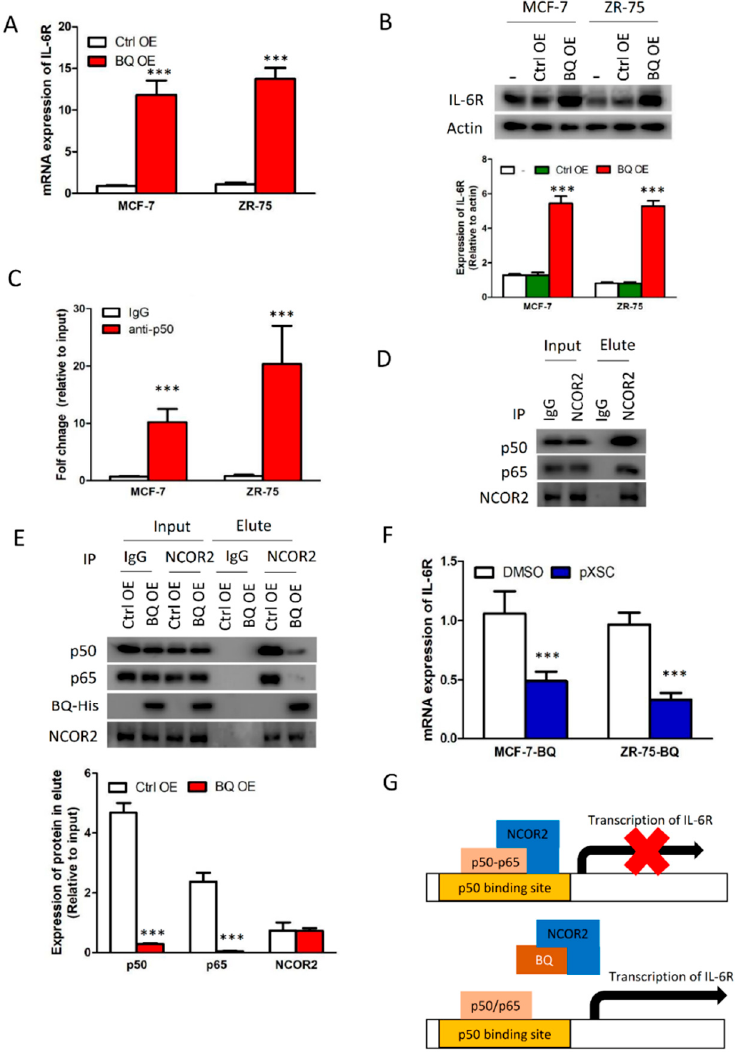
Figure 4. Overexpression of BQ could modulate the expression of IL-6 receptor (IL-6R) in breast cancer. Overexpression of BQ could enhance ( A ) mRNA and ( B ) protein levels of IL-6R. qPCR was performed to determine IL-6R expression in stable BQ-overexpressing cells and their control cells. Parental MCF-7 and ZR-75 were used as reference. Western blot was employed to determine IL-6R. Actin was used as loading control. ( C ) p50 could bind to the promoter of IL-6R. ChIP assay was performed with anti-p50. qPCR was used to detect the relative amount of DNA with the promoter of IL-6R. ( D ) NCOR2 could interact with p50 and p65. p50 and p65 are two subunits of NF-kB. Co-immunoprecipitation was performed on MCF-7. Anti-NCOR2 was used to immunoprecipitate the protein complex. Western blot was performed to determine the presence of the indicated protein candidates. ( E ) Overexpression of BQ could compromise the interaction between NCOR2 and NF-kB. Co-immunoprecipitation was performed on MCF-7 with anti-NCOR2. Western blot was employed to determine the presence of the indicated proteins in the immunoprecipitant. ( F ) Inhibition of NF-kB could suppress the expression of IL-6R in BQ overexpressing cells. Two hundred nanomolar of NF-kB inhibitor pXSC was used. The cells were treated for 72 h. qPCR was performed to determine IL-6R expression. Actin was used as internal control. ( G ) Schematic diagram showing the effect of BQ overexpression on the modulation of IL-6R expression through the NF-kB-dependent pathway. In the presence of BQ overexpression, BQ binds with NCOR2. This interaction compromises the ability of NCOR2 to bind to NF-kB to repress transcription mediated by NF-kB. Results were shown as mean ± SD from at least three independent experiments. Students’ t test was used to determine the statistical significance between two groups. *** represents p <